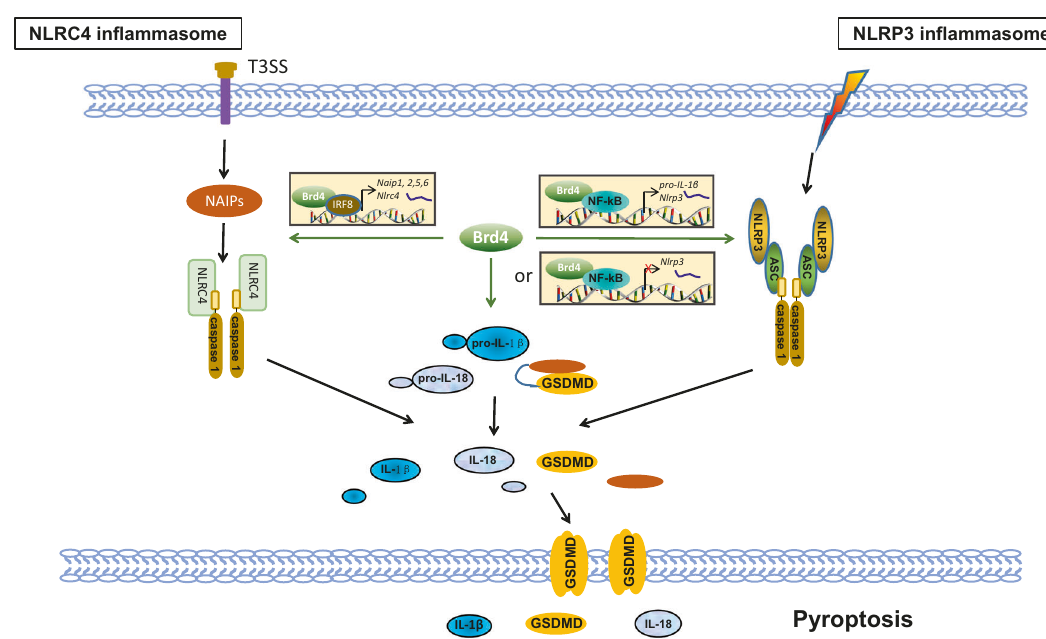
Fig. 4 Schematic model for the regulation of Brd4 in pyroptosis. Brd4 transcriptionally upregulates the expression of pro-IL-1 β , NAIP1, 2, 5, 6 and NLRC4. Brd4 upregulates or downregulates NLRP3 expression depending on the